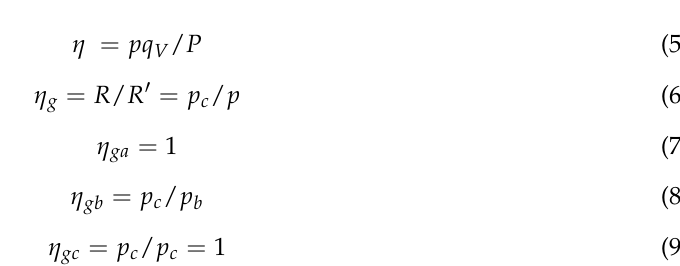
Figure 8. The adjustment progress of the fan.